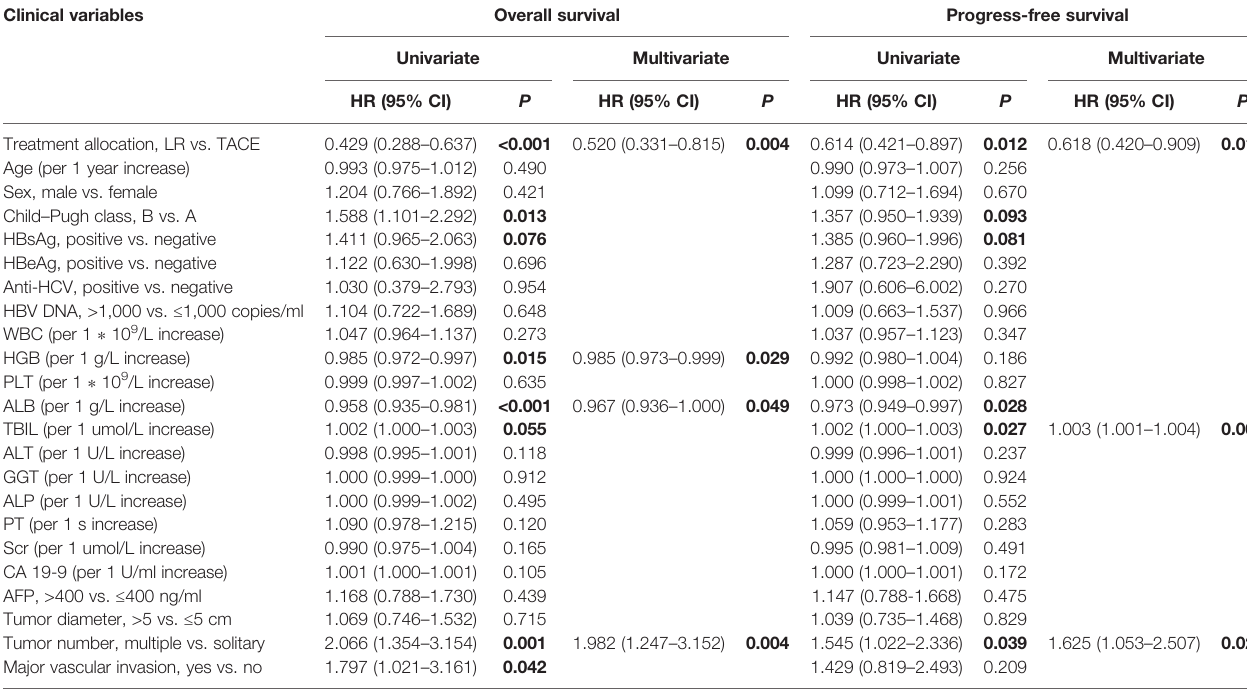
HCC, hepatocellular carcinoma; BDTT, bile duct tumor thrombus; TACE, transarterial chemoembolization; CM, conservative management; HBsAg, hepatitis B surface antigen; HBeAg, hepatitis B e antigen; HCV, hepatitis C virus; HBV DNA; hepatitis B virus deoxyribonucleic acid; WBC, white blood cell; HGB, hemoglobin; PLT, platelet; ALB, albumin; TBIL, total bilirubin; ALT,alanineaminotransferase;GGT, g -glutamyltransferase;ALP,alkalinephosphatase;PT,prothrombintime;Scr,serumcreatinine;CA19-9,carbohydrateantigen19-9;AFP, a -fetoprotein. Statistically signi fi cant values are depicted as bold